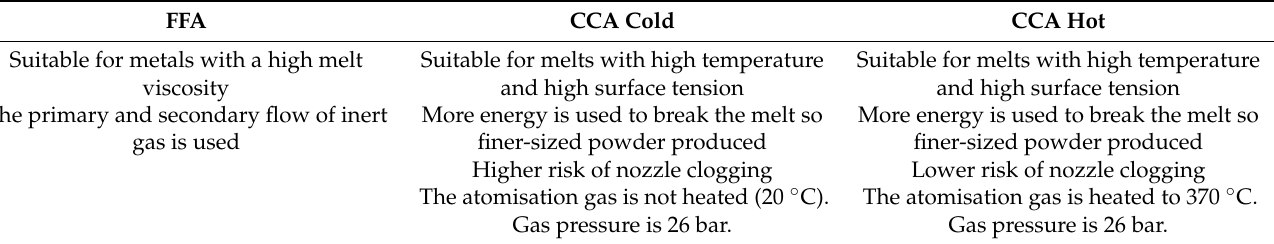
Table 2. Relevant data of different atomisation routes used for powder production. FFA CCA Cold CCA Hot Suitable for melts with high temperature Suitable for melts with high temperature viscosity and high surface tension and high surface